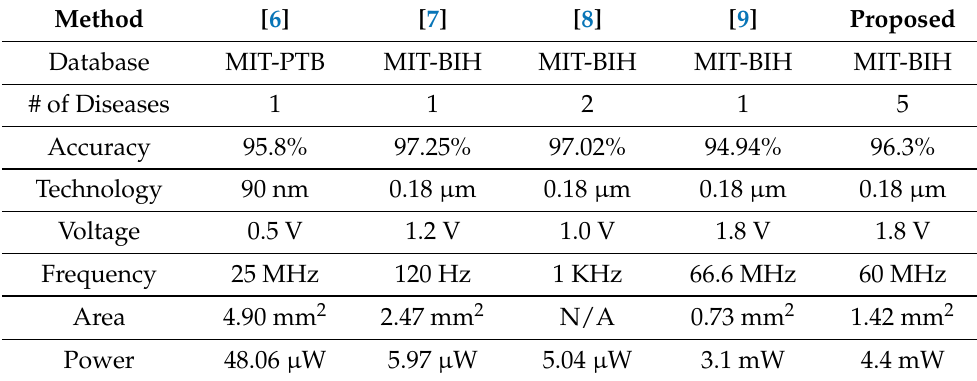
Table 5. Performance comparison of the proposed circuit and a number of existing works.